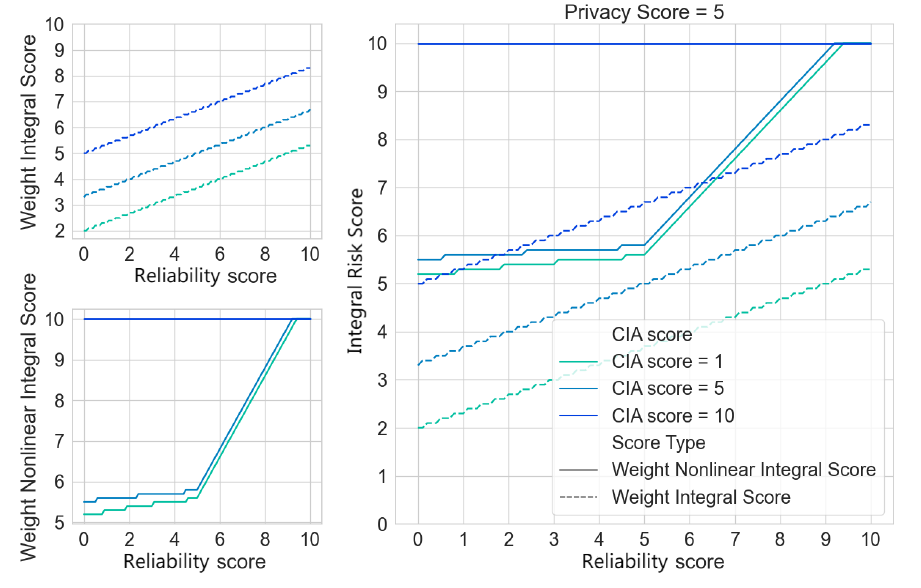
Figure 1. The character of the integral risk scores calculated using weighted sum function (weight integral score) and proposed nonlinear weight function (weight nonlinear integral score) for three metrics being integrated: privacy score set to 5, CIA score set to 1, 5, and 10, and reliability score varying from 0 to